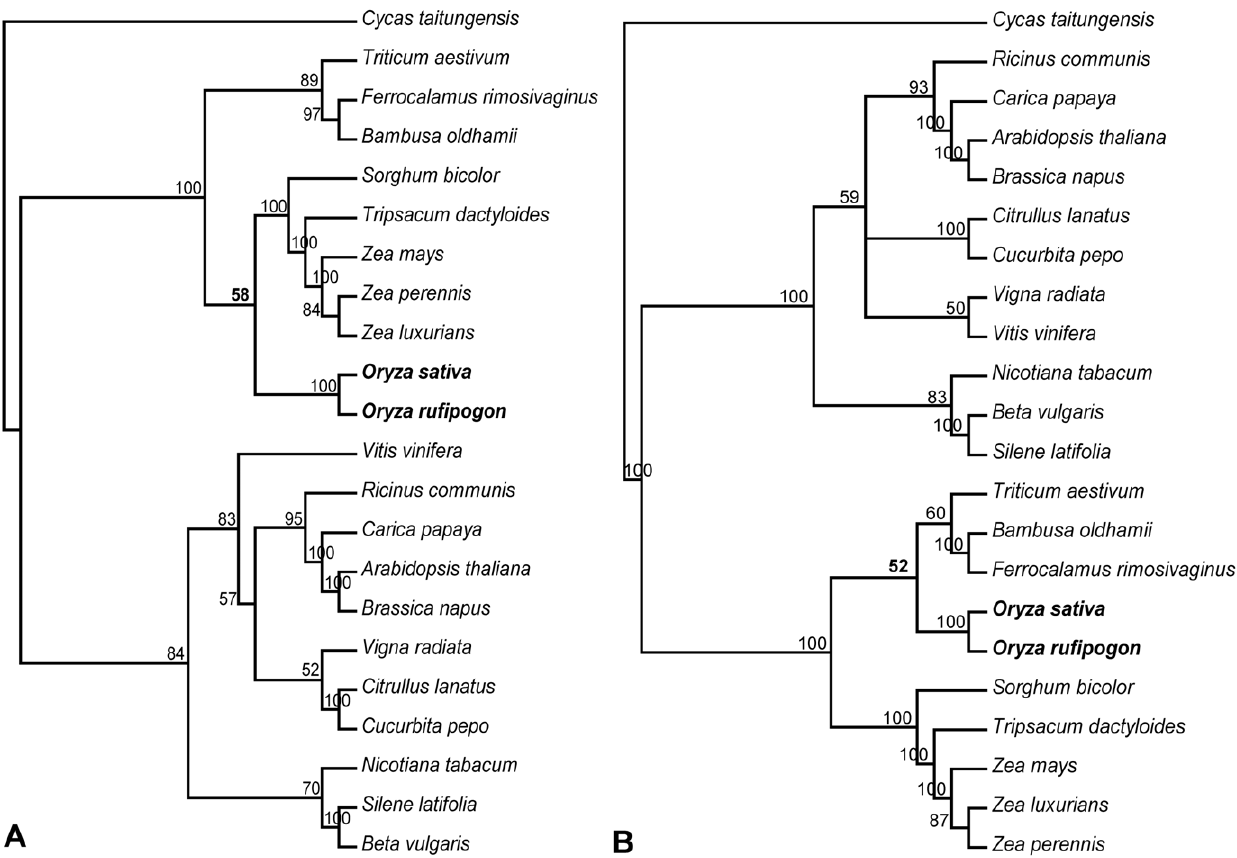
Figure 2. Phylogenetic trees of 22 seed plants based on amino acid sequences of 31 mitochondrial genes. The ML tree (A) and the MP tree (B). Numbers associated with branches are bootstrap support (BS) values. Oryza and related BS values indicated in bold.